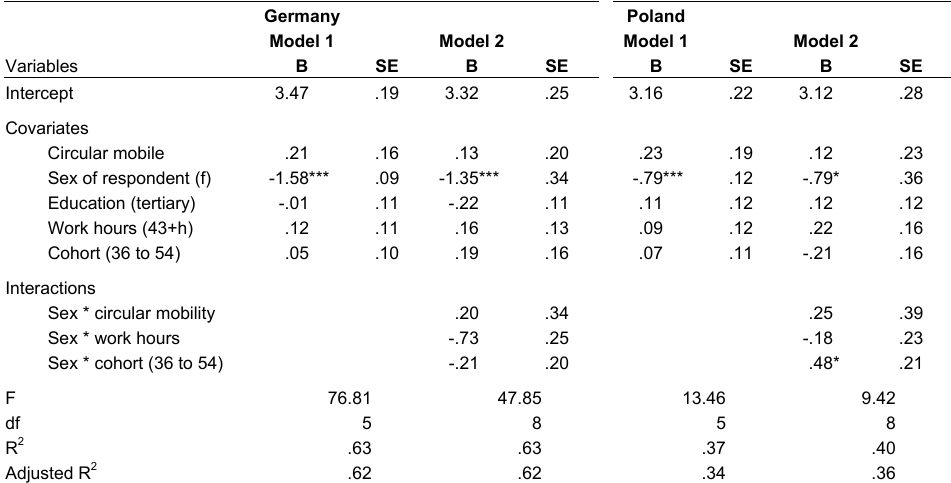
.63 .63 .37 .40 Adjusted R 2 .62 .62